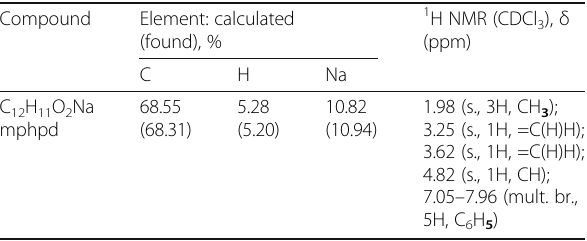
Table 1 Analytical and 1 H NMR data for Na(mphpd) Compound Element: calculated (found),